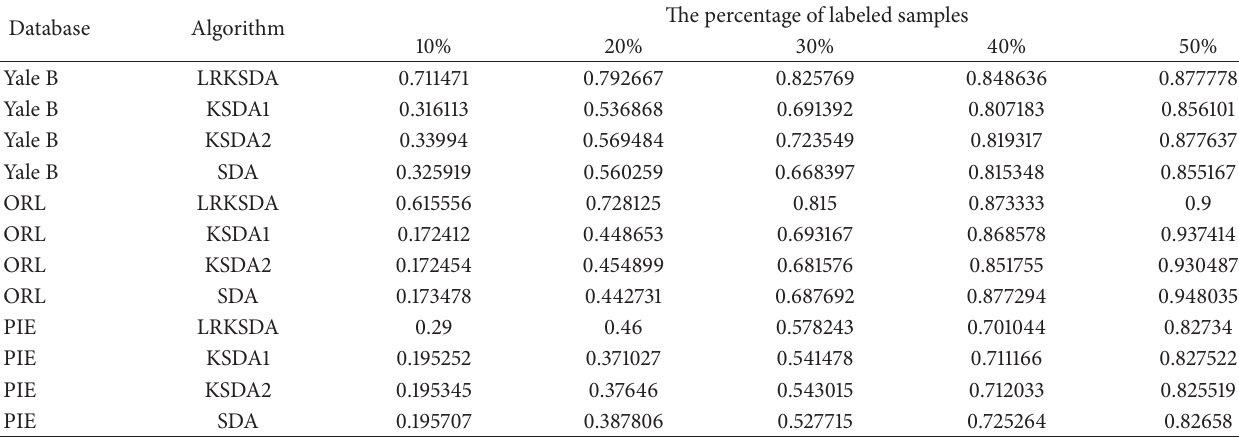
Table 2: Classification accuracy of different graphs on ORL, Yale, and USPS